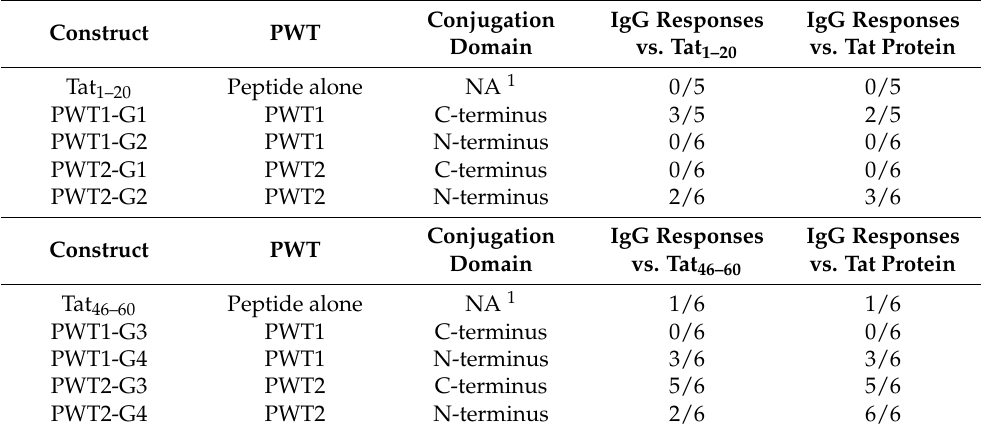
Table 1. Numbers of mice with detectable humoral responses after